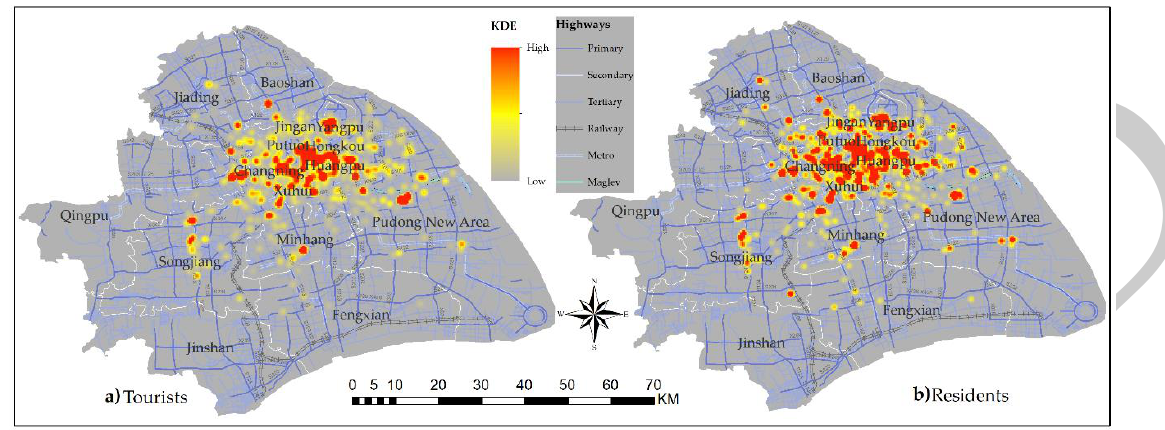
Figure 8. Kernel density estimation Heatmaps for tourists’ and residents’ check-in activity in Shanghai.